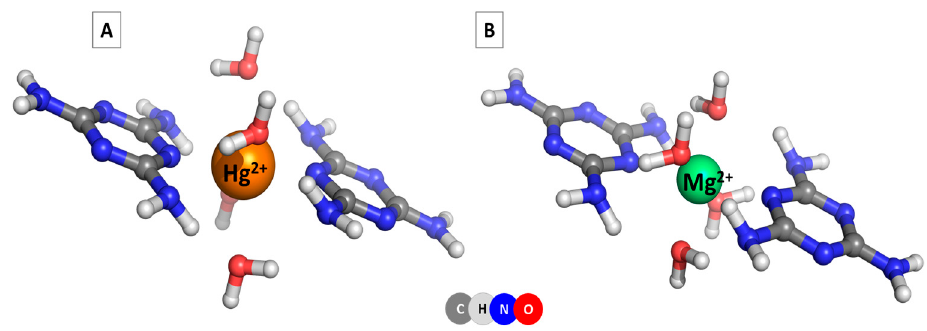
Figure 9. TAT-hydrated metal complexes at 2:1 stoichiometry: ( A ) TAT-hydrated Hg 2+ complex and ( B ) TAT-hydrated Mg 2+ complex.